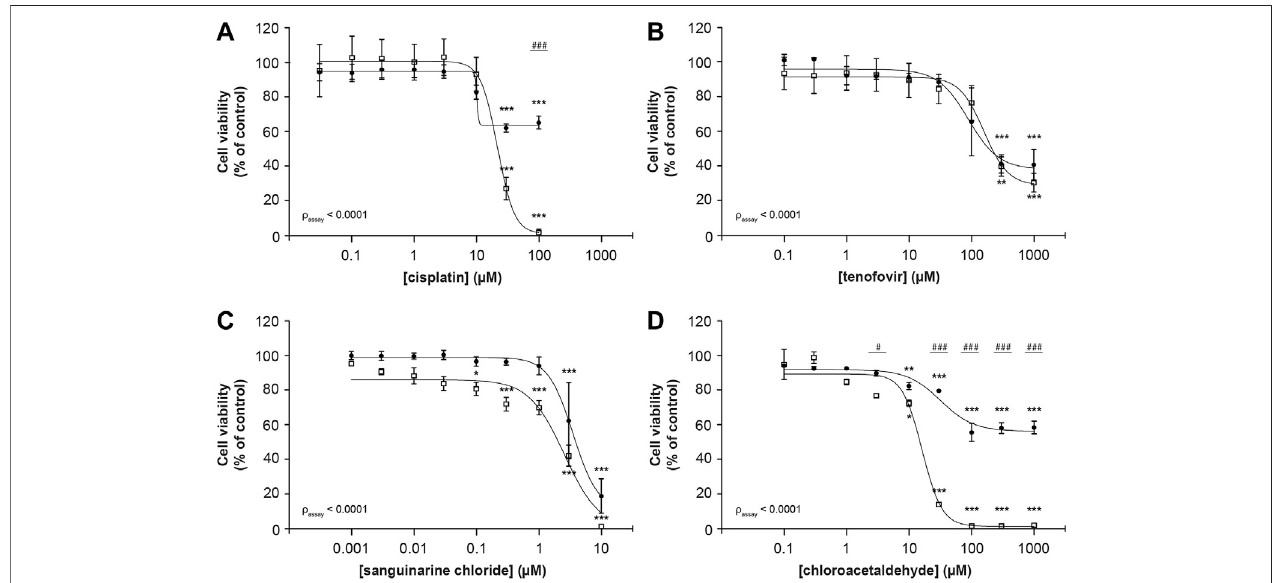
FIGURE 2 | Comparison of MTT and fl uorescence-based cell death methods to assess concentration-dependent reduction of ciPTEC cellular viability. Cellular (cid:129) metabolicactivity( □ )and fl uorescence-basedcelldeath( )weredetermined inciPTEC-OAT1after24 hincubationwithaserial √ 10-dilutionofnephrotoxiccompounds (A) cisplatin, (B) tenofovir, (C) sanguinarine chloride and (D) chloroacetaldehyde. All results were normalized to unexposed controls. Statistical analyses: one-way ANOVAcorrectedformultiplecomparisonbyDunnett ’ s posthoc analysistocomparedifferencesbetweenvehiclecontrolandexposedconditions* p < 0.05,** p < 0.01, *** p < 0.001; and two-way ANOVA corrected for multiple comparison by Bonferroni ’ s post hoc analysis to compare differences between assays # p < 0.05, ### p < 0.001. p -value corresponding to overall signi fi cance between assays is indicated for each compound. Mean ± SEM; n = 3 independent experiments.